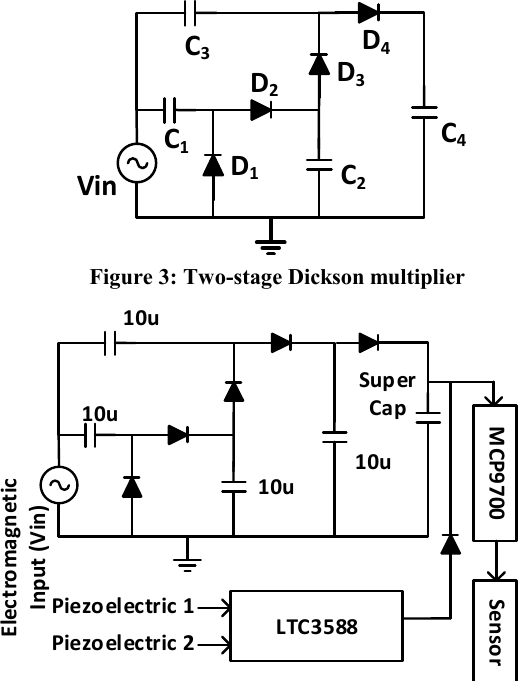
Figure 4: Power conditioning circuit, LTC3588